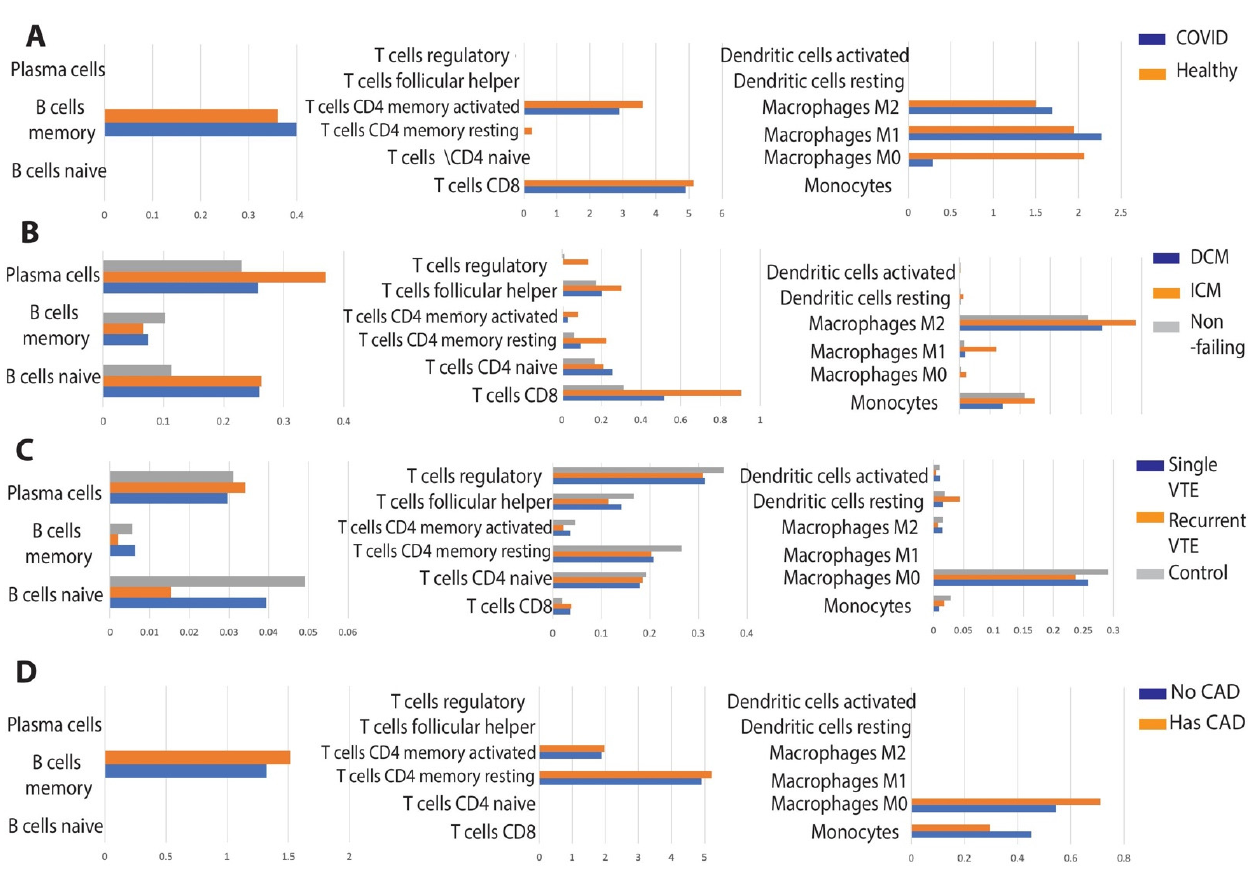
Figure A1. Bar charts comparing immune cell infiltration between ( A ) COVID-19, ( B ) ischemic cardiomyopathy/ non- ischemic dilated cardiomyopathy, ( C ) single venous thromboembolism (VTE)/recurrent VTE, and ( D ) coronary artery disease patients.